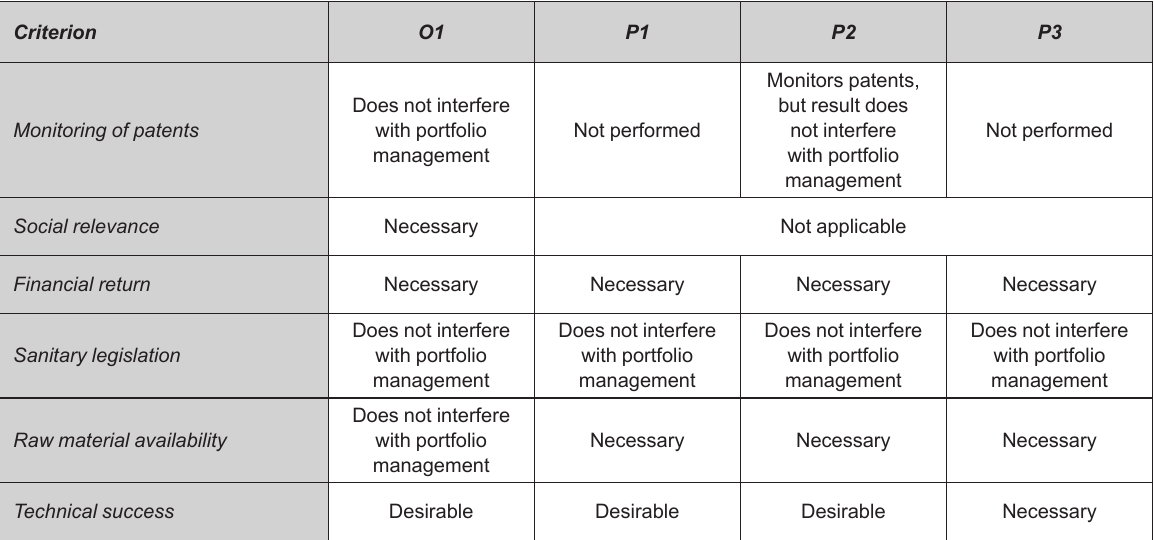
FIGURE 4 – Classification of key criteria in the assessed